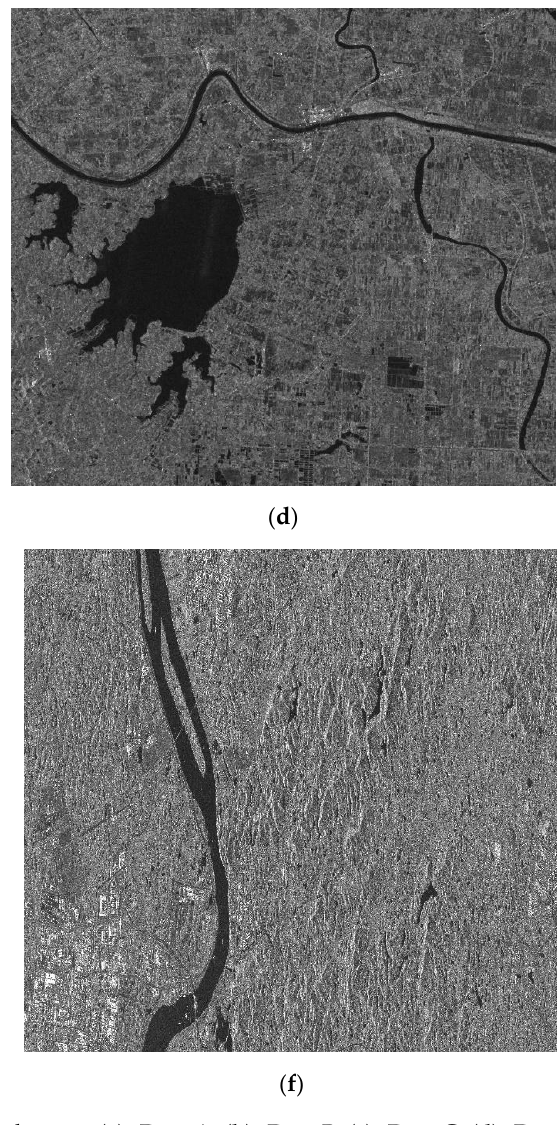
Figure A1. The SAR images from Data A to Data F of the study area. ( a ): Data A, ( b ): Data B, ( c ): Data C, ( d ): Data D,( e ):Data E, ( f ):Data F.